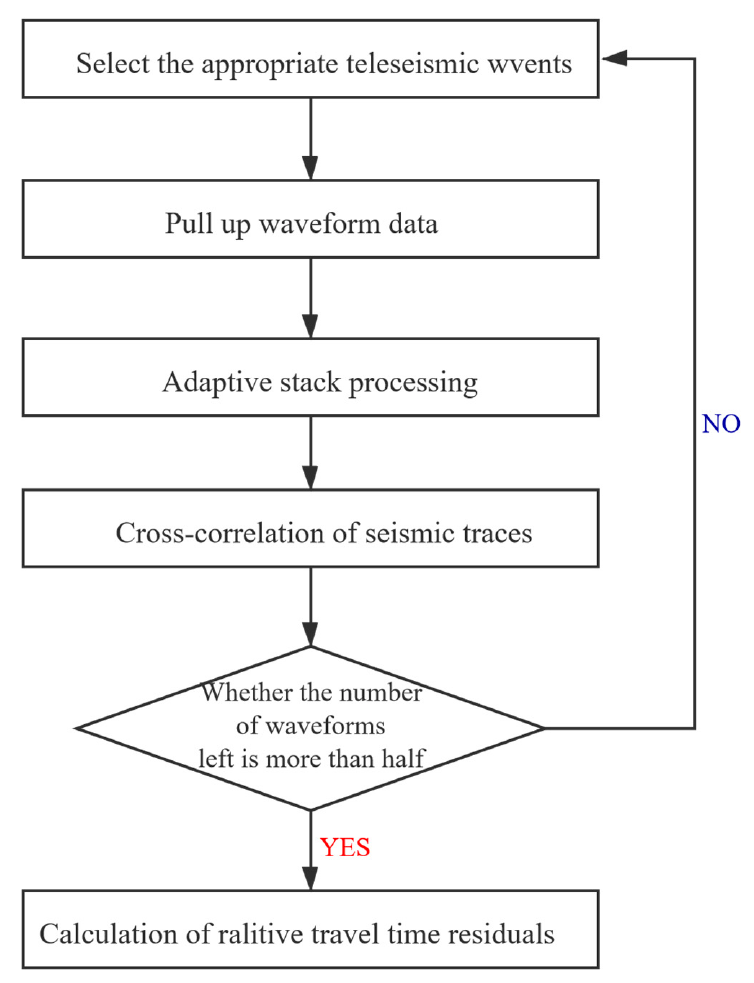
Figure 3. Flowchart of picking up relative travel time residuals from raw seismic waveform data (modified from Jia, Z. [39]).